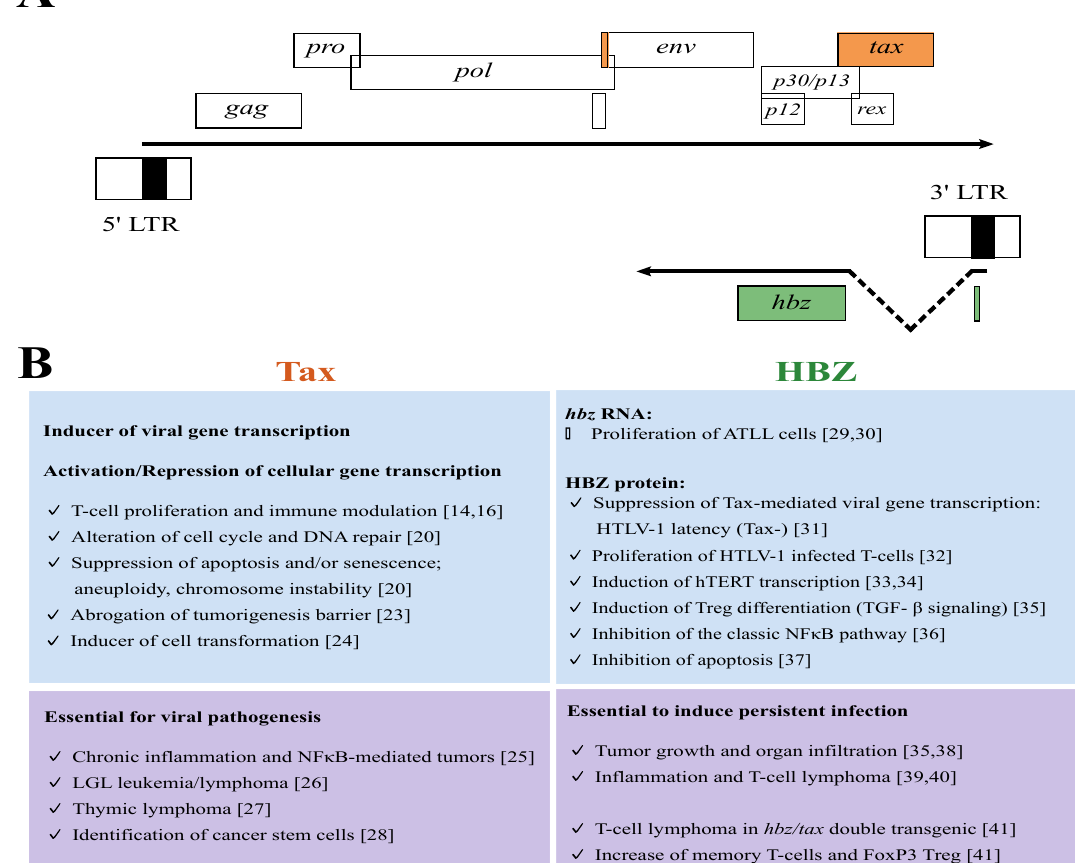
Figure 1. Activities of HTLV-1 Tax and HBZ regulatory proteins in vitro and in vivo . ( A ) The scheme of HTLV-1 genome showing the sense and antisense genes; these genes are flanked by the long terminal repeats (LTR); (upper part) sense transcripts are initiated in the 5' LTR containing the promoter region and terminate in the 3' LTR; (lower part) antisense transcripts are initiated in the 3' LTR. Coding exons for regulatory proteins are presented as orange box for Tax and green box for HBZ; ( B ) Major roles of Tax and HBZ regulatory proteins reported from experiments using cell culture (upper panel) or transgenic mouse models (lower panel).